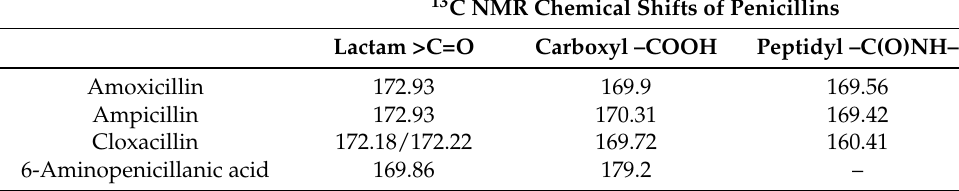
Table 1. 13 C NMR characteristics of penicillins.